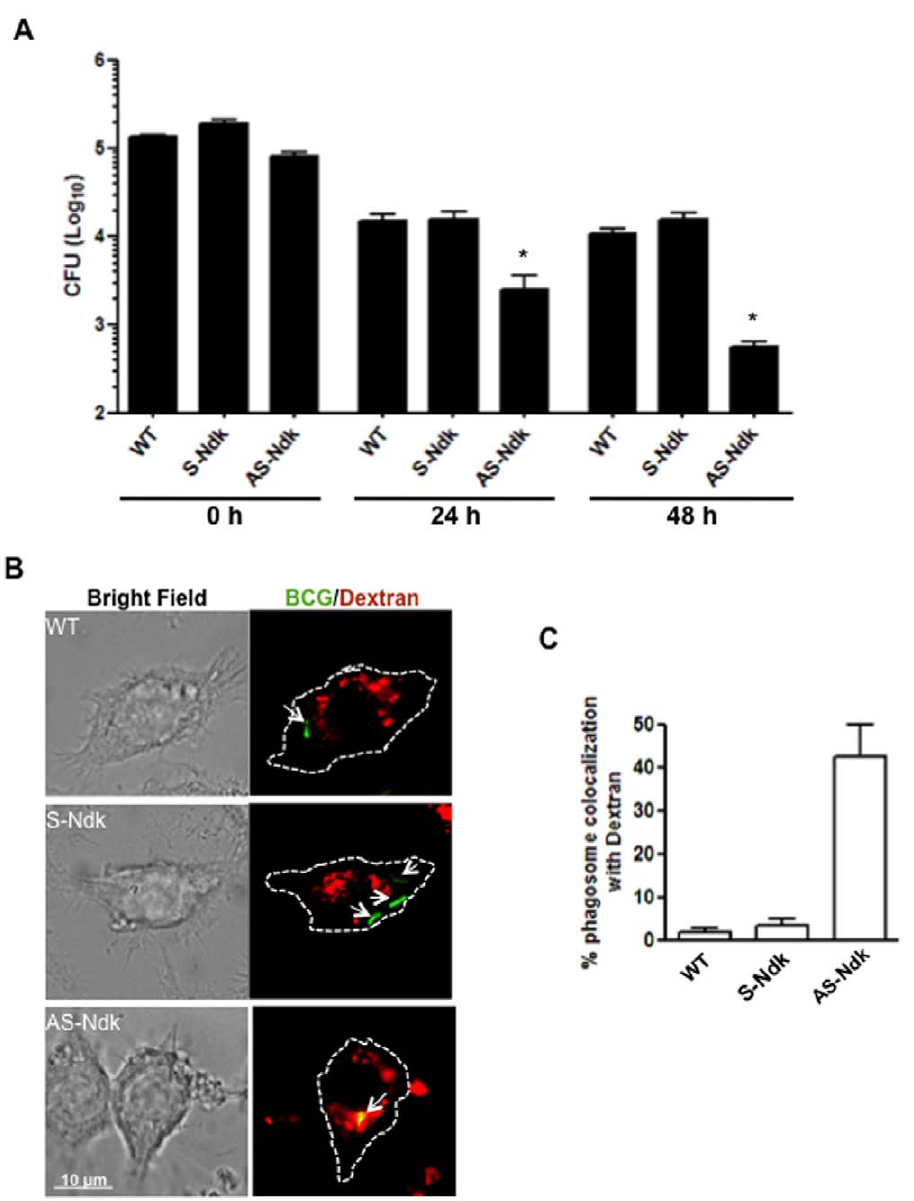
Figure 6. BCG-AS 2 Ndk has decreased intracellular survival due to increased phagolysosome fusion. A. RAW macrophages were infected with BCG strains (MOI of 10:1). Then culture media was supplemented with 50 m g/ml gentamicin to kill extracellular non-ingested mycobacteria. Cells were washed three times in PBS and lysed in 0.025% SDS 1 h (0 h time point), 24 h, and 48 h post-infection. Serial dilutions of recovered bacteria were then plated on solid 7H10 media supplemented with 10% OADC. CFU counts were performed after 3 weeks incubation at 37 u C,. Bars, mean 6 s.e.m. (three independent experiments). B. RAW cells adherent to cover slips were loaded with 0.5 mg/ml Texas Red-Dextran overnight and then infected with FITC-labelled BCG strains (wild-type: WT, expression of sense (S-), or antisense (AS-) Ndk) at an MOI of 20:1. At 4 h post-phagocytosis, cells were fixed with 2.5% paraformaldehyde and mounted onto slides for confocal analysis. Bright field and merged fluorescent images are shown with an outline of the cell boundaries. Green signal indicates BCG that are not colocalized with dextran, while yellow signal shows colocalization of BCG with lysosomes. C. Quantification of data shown in panel B. doi:10.1371/journal.pone.0008769.g006 interacting effector EEA1 to phagosomes containing Ndk-coated the EEA1 FYVE domain to PI3P stabilizes the interaction between latex beads. Thus, while SapM decreases EEA1 recruitment Rab5 and EEA1 [47]. As EEA1 was shown to be excluded from Mtb through hydrolysis of phagosomal PI3P [22], Ndk is acting through and BCG phagosomes by a mechanism dependent on mycobac- Rab5-GTP deactivation and attenuation of its interaction with terial lipid phosphatase SapM [22], we examined an alternate hVPS34 leading ultimately to diminished phosphorylation of PI on mechanism mediated by mycobacterial GAP activity towards Rab5 the phagosomal membrane. This conclusion is consistent with GTPase. This hypothesis was confirmed by the demonstration of previous findings that hVPS34 catalytic activity begins after binding direct binding of Ndk to Rab5-GTP and its dephosphorylation, to GTP-bound Rab5 [37]. consistent with the observation of reduced recruitment of the Rab5